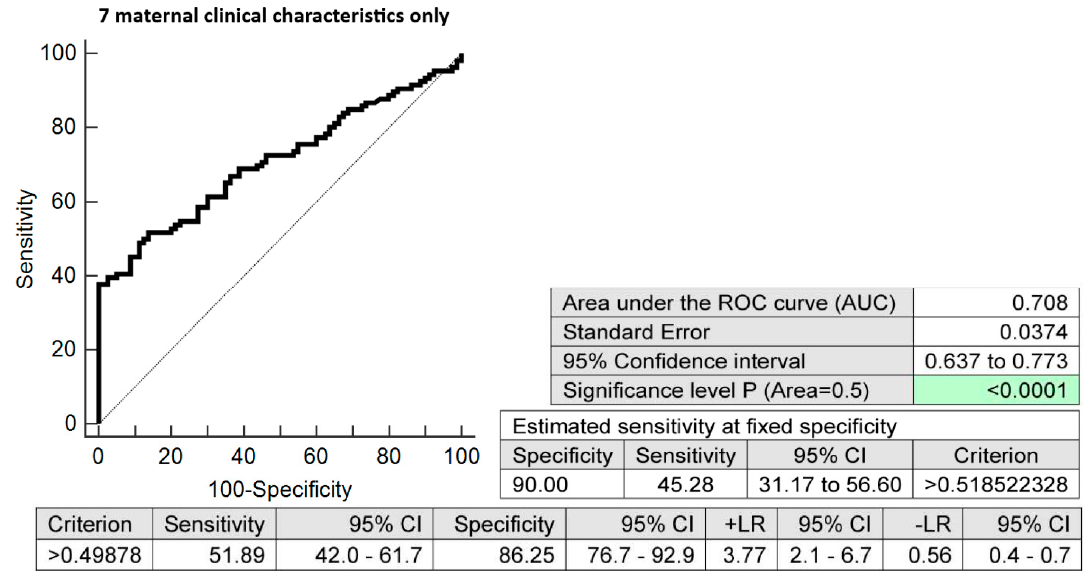
Figure 5. Combination of seven maternal clinical characteristics only (maternal age and BMI values at early stages of gestation, infertility treatment with assisted reproductive technology, the